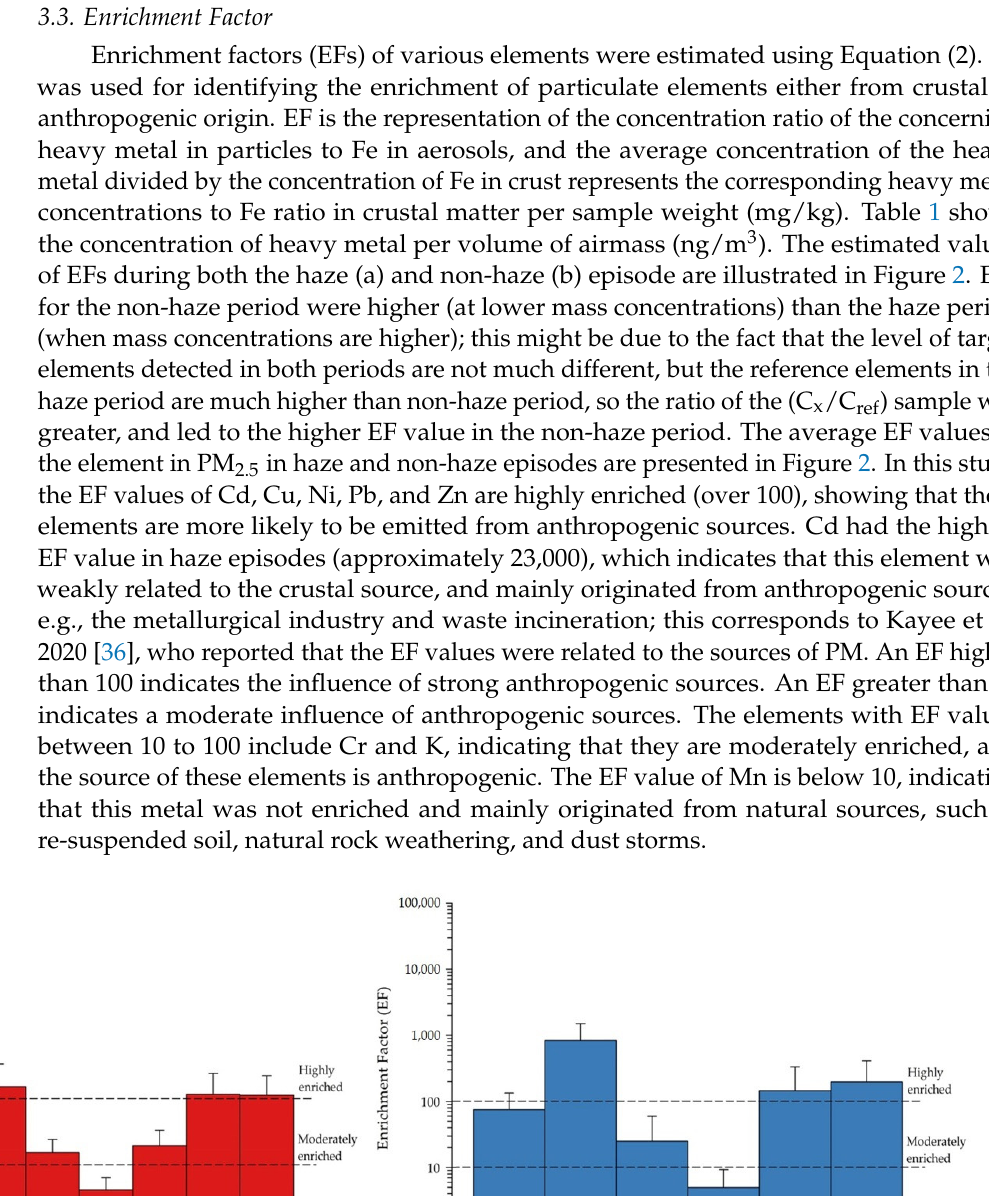
Table 3. Comparison of the element indices values between haze episode and non-haze episode using the Mann–Whitney U test.